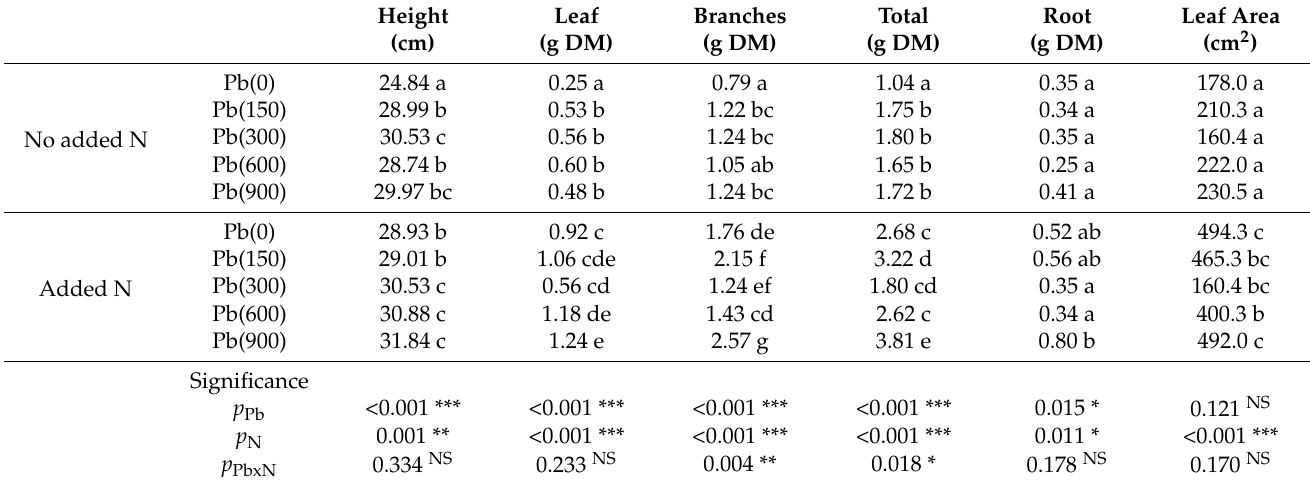
Table 2. Plant parameters in the purslane cultivated in soil with added Pb with and without N.